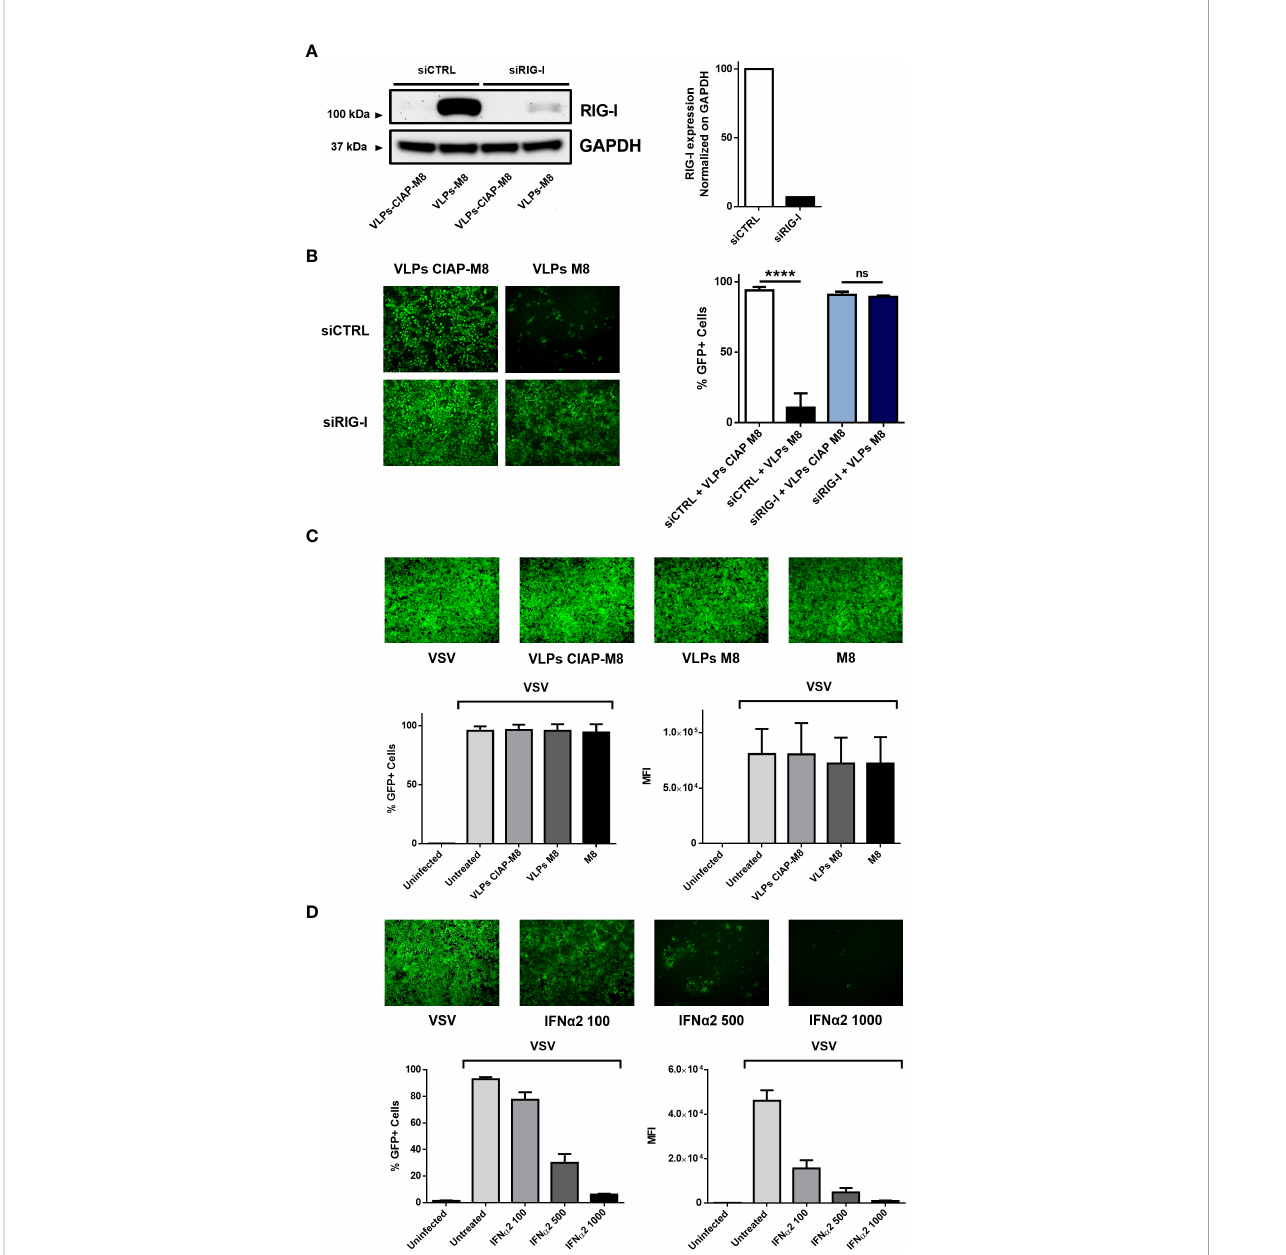
FIGURE 3 VLPs-M8 activity relies on RIG-I and type-I IFN signaling. (A) RIG-I expression in A549 cells. A549 cells were transfected with 10pmol of scrambled siRNA (siCTRL) or siRIG-I for 72h and immunoblot analysis of RIG-I expression was performed on whole cell extract; GAPDH was used as endogenous control for normalization. On the right, schematic representation of RIG-I protein expression, normalized on GAPDH and indicated as folds over control (siCTRL) set as 100. Image Lab software was used to quantify the protein bands and ratio was calculated by using software volume tool comparing lanes 2 and 4 (Bio-Rad, Hercules, CA, USA). (B) VSV-GFP infection in silenced A549 cells. Left, fl uorescence microscopy images representative of A549 cells silenced with a scrambled siRNA (siCTRL) or siRIG-I for 24h, then treated with the indicated VLPs for 48h and infected with VSV-GFP (MOI 1) for further 24h. On the right, fl ow cytometry analysis indicating the percentage of GFP + silenced A549 cells treated with VLPs and infected for 24 with VSV-GFP (MOI 1). (C) VSV-GFP infection in VERO E6 cells. Upper panel shows fl uorescence microscopy images representative of VERO E6 treated with the indicated VLPs or M8 (10ng) directly transfected into cells and infected with VSV-GFP (MOI 0.1) for 24h. Bottom panels show fl ow cytometry analysis of percentage of GFP + cells (left) and Mean Fluorescence Intensity (right). (D) VSV-GFP infection in VERO E6 cells treated with IFN a 2. Upper panel shows fl uorescence microscopy images representative of VERO E6 treated with increasing concentrations of IFN a 2 (U/ml) for 24h and infected with VSV-GFP (MOI 0.1) for further 24h. Bottom panels show fl ow cytometry analysis of percentage of GFP + cells (left) and Mean Fluorescence Intensity (right). Fluorescence images in (B-D) were obtained using a Olympus fl uorescence microscope (10x magni fi cation) and analyzed by ImageJ. Data represent mean+SEM from 3 independent experiments. Statistical signi fi cance was de fi ned as follows: ****p<0.0001, ns, not signi fi